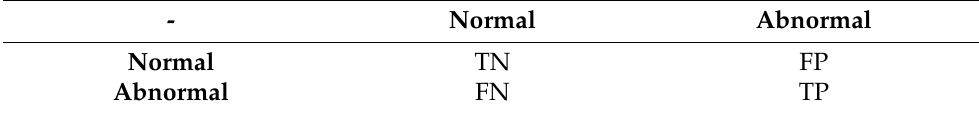
Table 4. Confusion matrix for binary